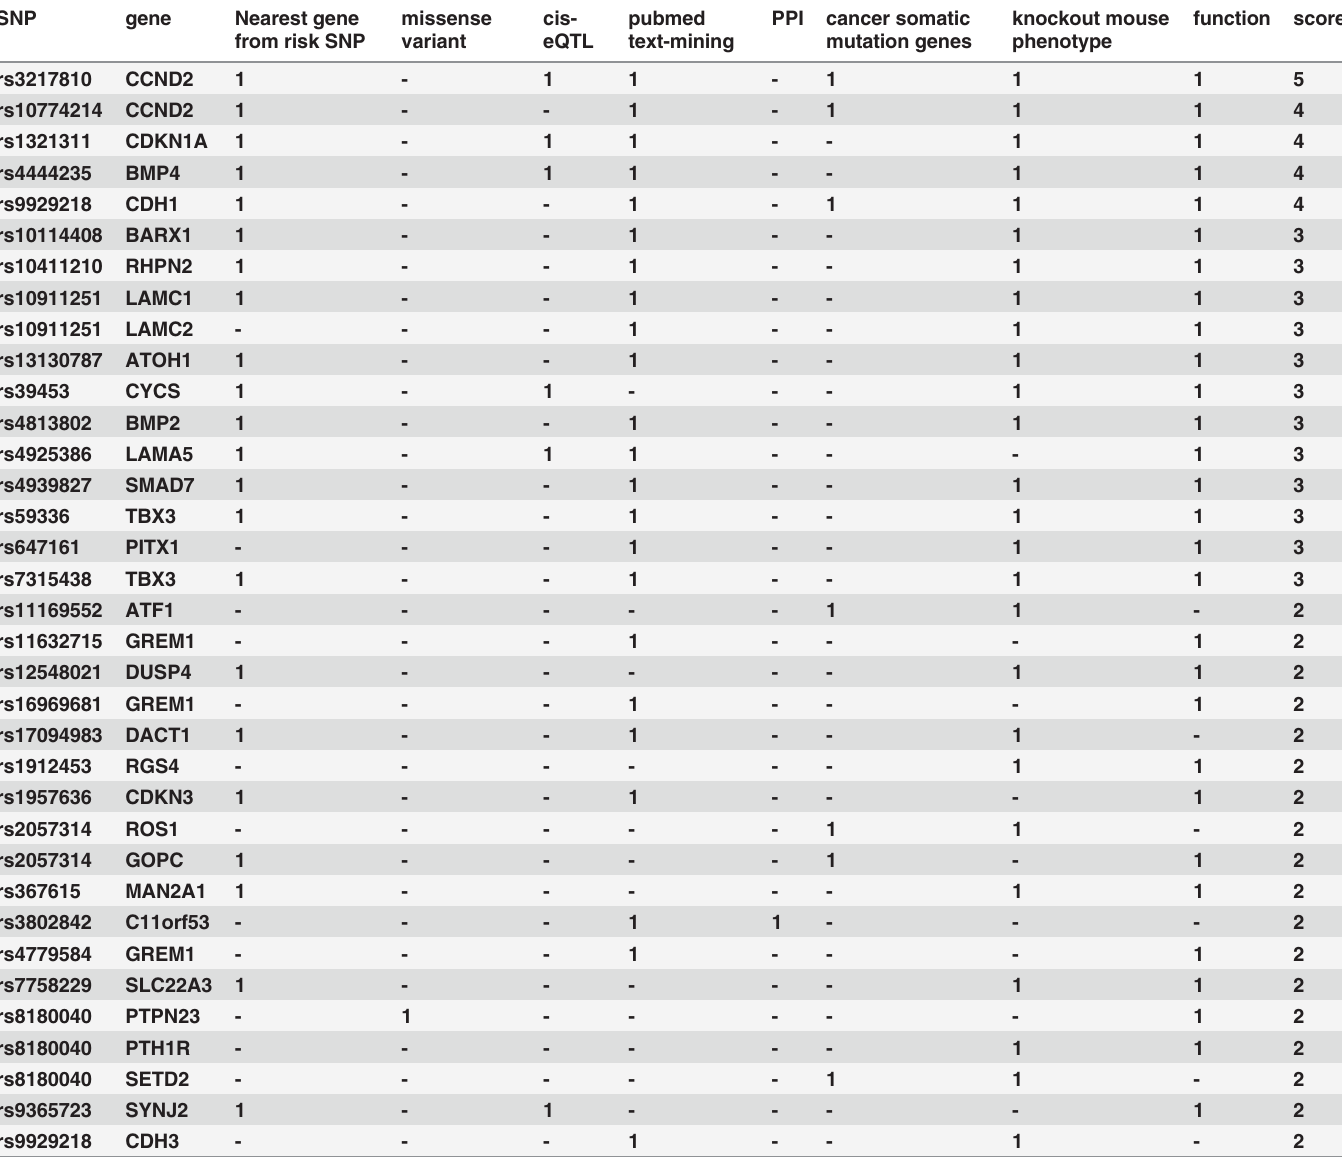
Table 2. Biological genes in the CRC risk loci with a score (cid:2)